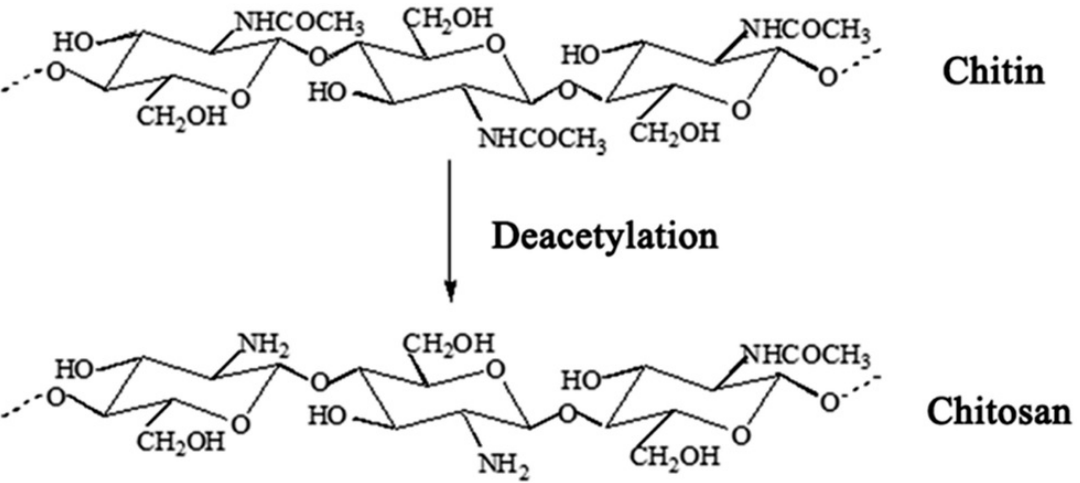
Figure 1. The chemical structure of chitin and chitosan.